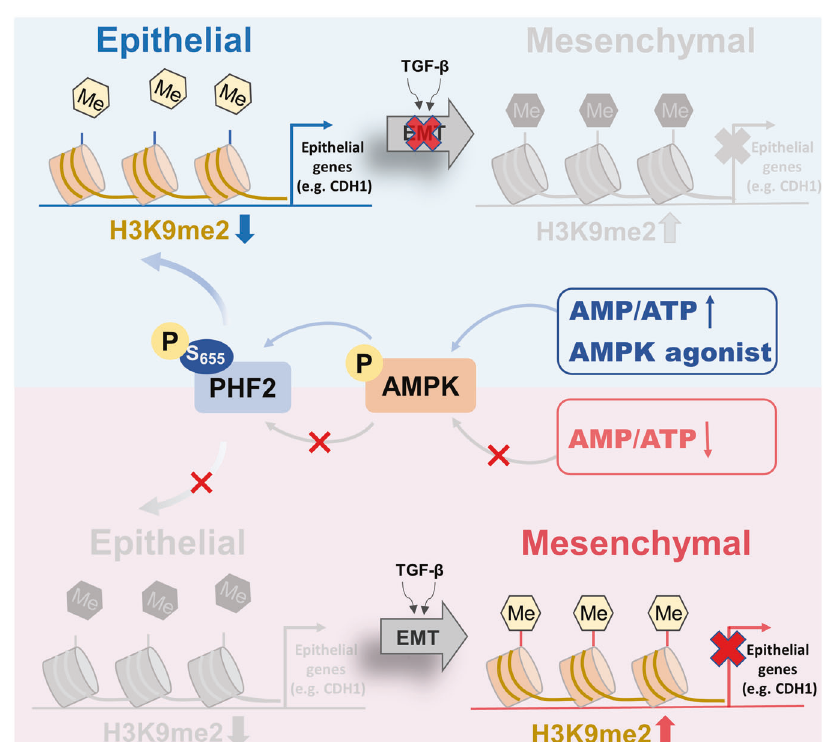
Fig. 8 Schematic depicting the molecular mechanism through which AMPK epigenetically inhibits lung cancer metastasis. AMPK activation promotes PHF2-S655 phosphorylation, which enhances the H3K9me2 demethylation activity of PHF2 and triggers the transcription of epithelial genes, thus inhibiting EMT processes. The fi gure was drawn by using